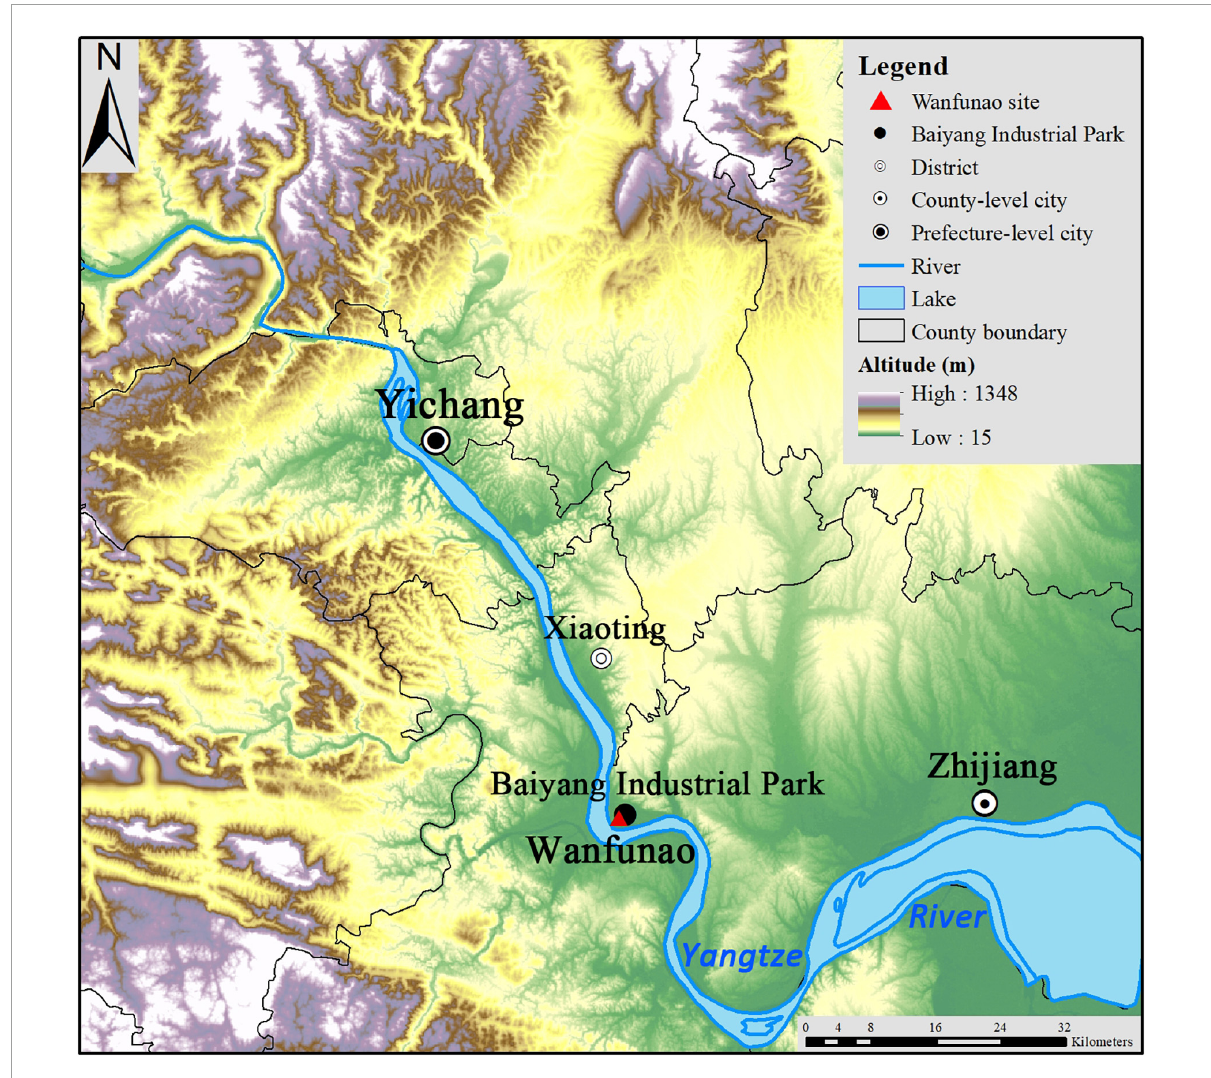
FIGURE2 Regional landforms around Wanfunao